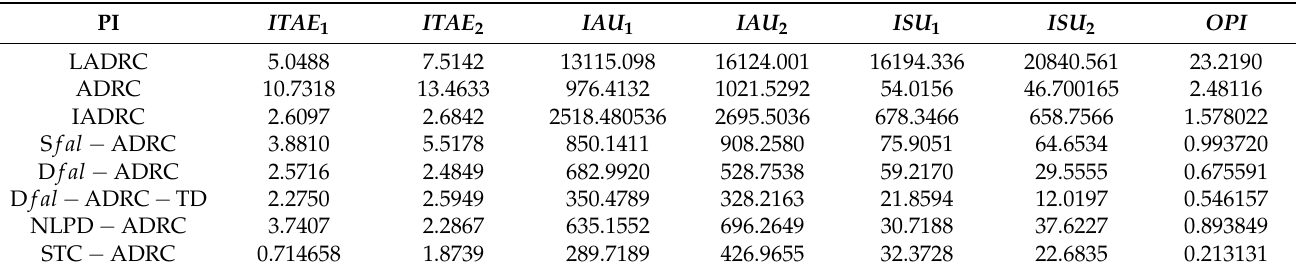
Table 14. Performance